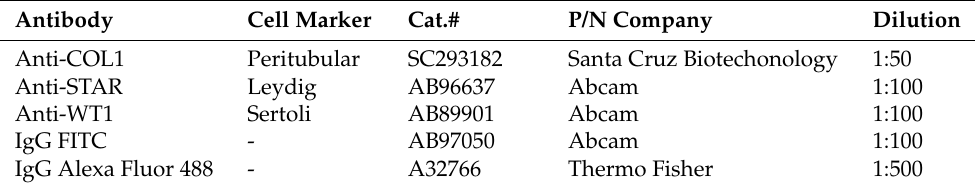
Table 1. Antibodies used for testicular cell-specific marker